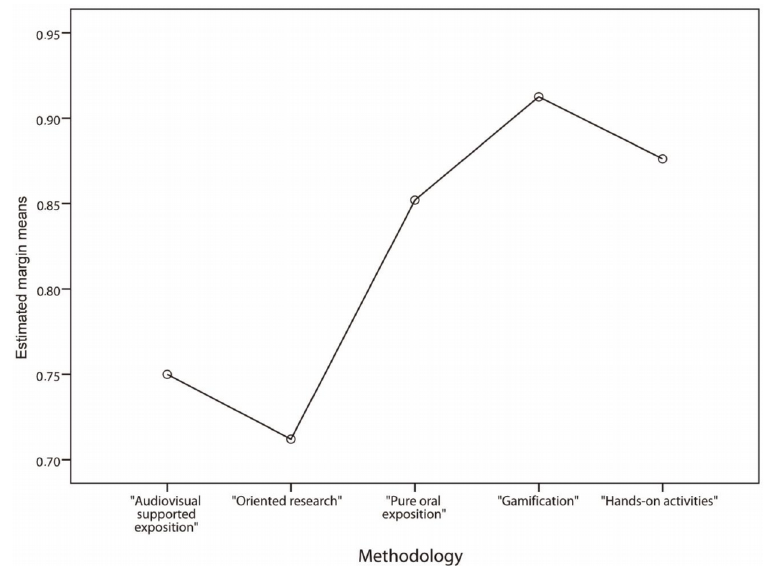
Figure 2. Estimated marginal means for Positive Emotions vs Teaching Method